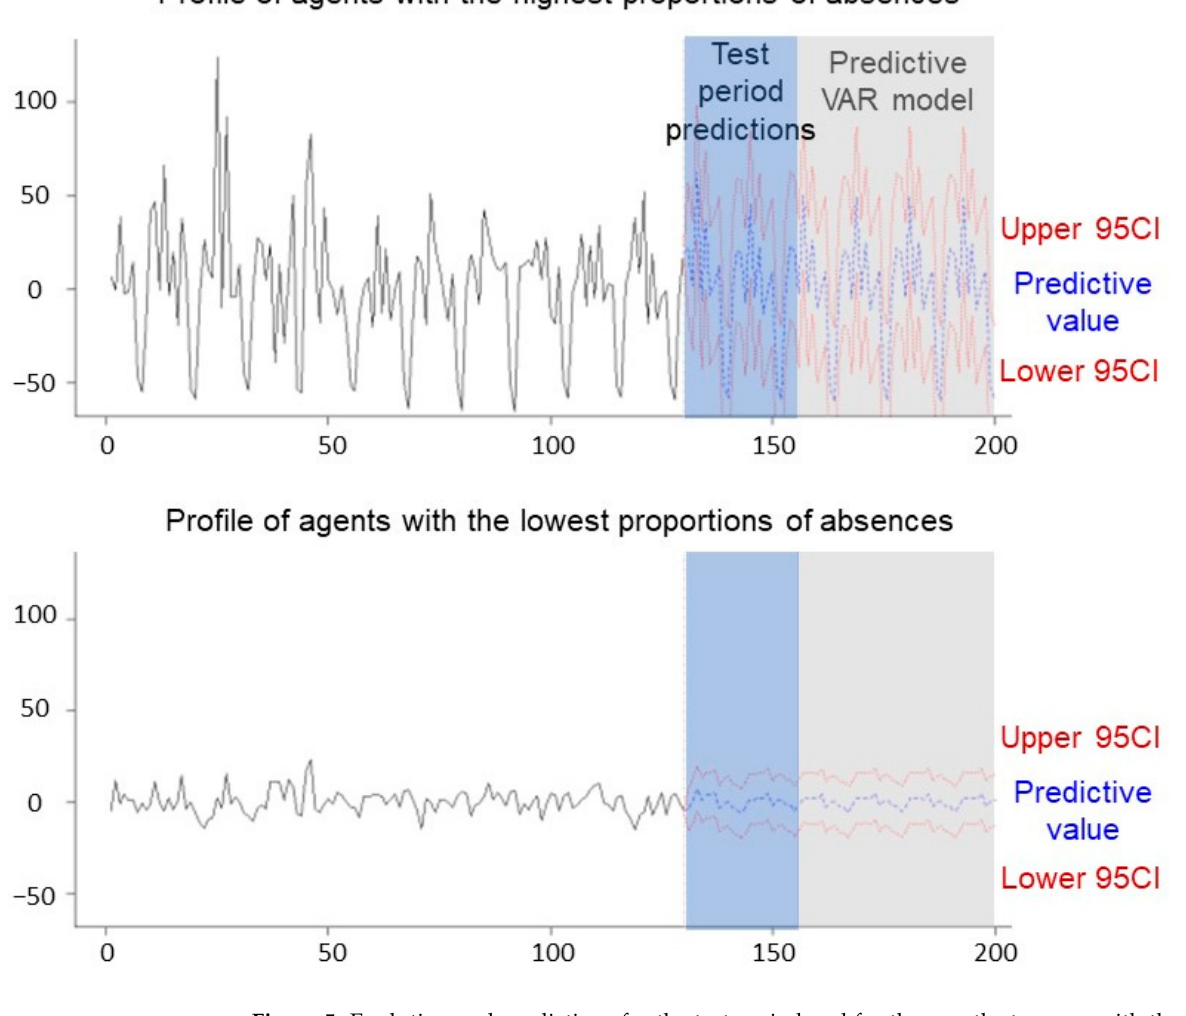
Figure 5. Evolution and predictions for the test period and for the months to come with the VAR model of the PCA components. The first component represents the factors of people with the highest proportions of absences, and the second component represents the factors of people with the lowest proportions of